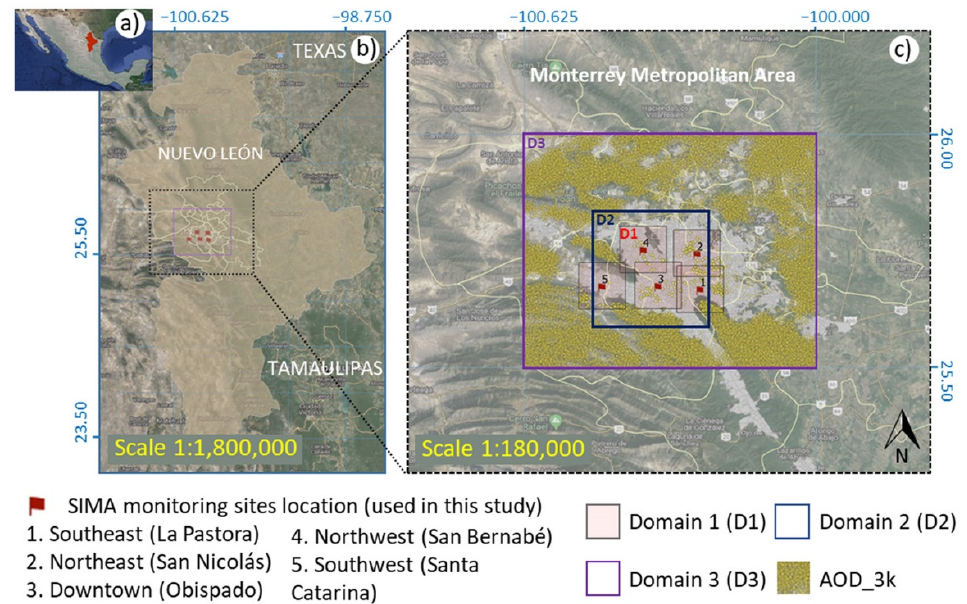
Figure 1. Study area location, ground-based data, and the moderate-resolution imaging spectrora- diometer (MODIS) aerosol optical depth (AOD) spatial collocation. ( a ) The State of Nuevo León (shown in red) is located in northeastern Mexico. ( b ) The Monterrey Metropolitan Area (MMA) is the main urban area in the state of Nuevo Le ó n. ( c ) Three spatial domains were used D1, D2, and D3. An example of AOD distribution using the MYD04_3k MODIS product (AOD_3K) covering the three domains (D1, D2, and D3) for the period 2010 to 2017 is also